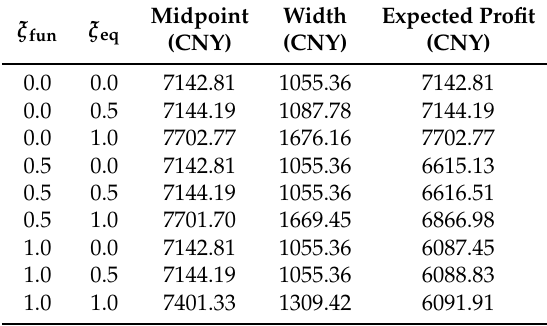
Table 5. Profit intervals of the